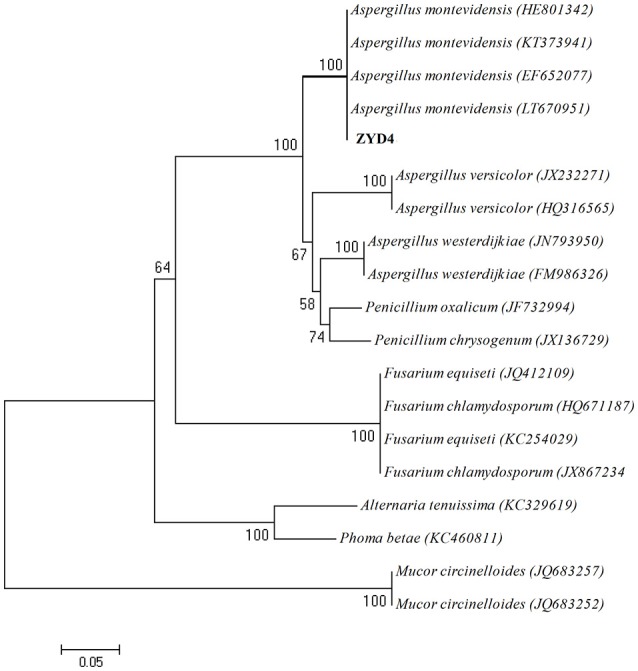
Neighbor-joining tree showing the phylogenetic relationship of the strain ZYD4. Boot strap values (expressed as percentages of 1,000 replications) >50% was given at the node.